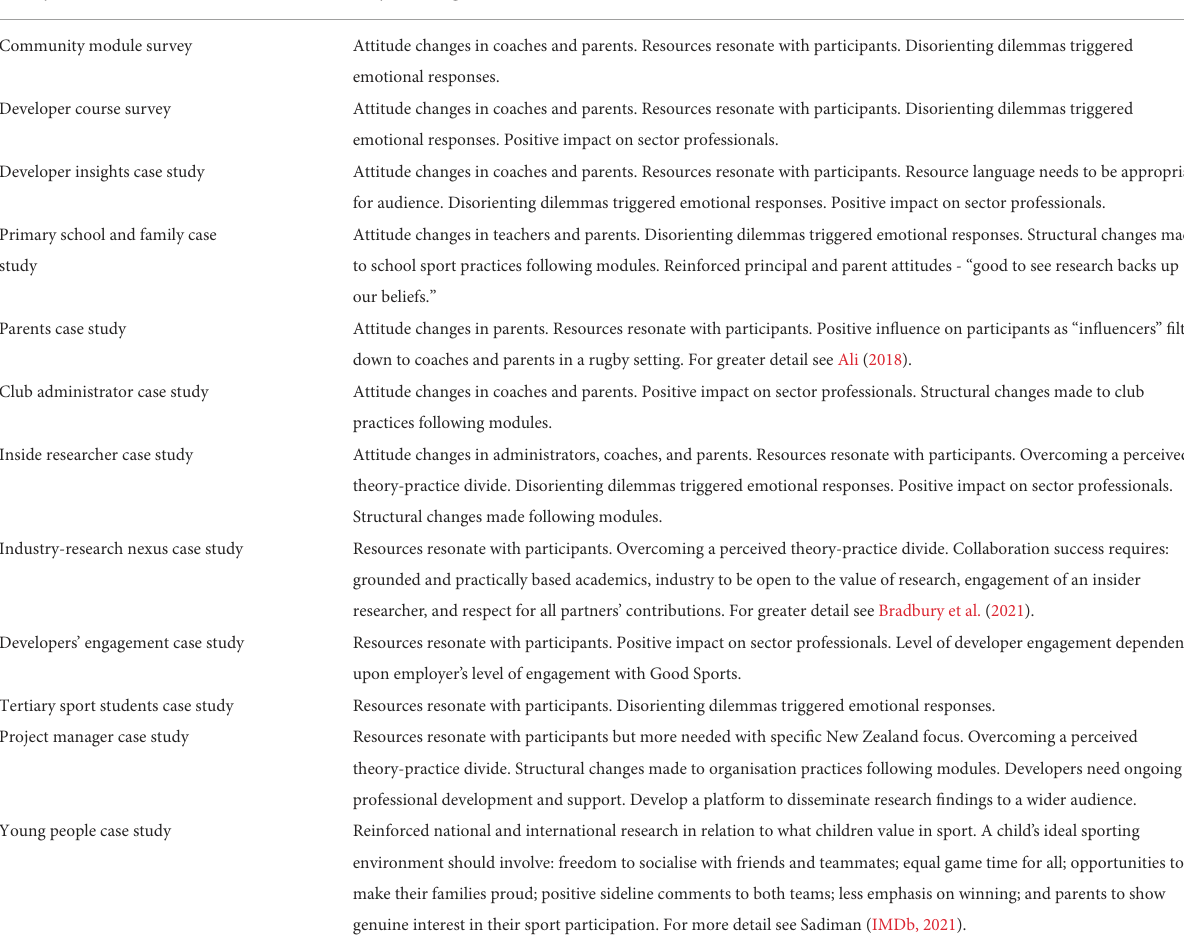
TABLE 3 Key findings of good sports’